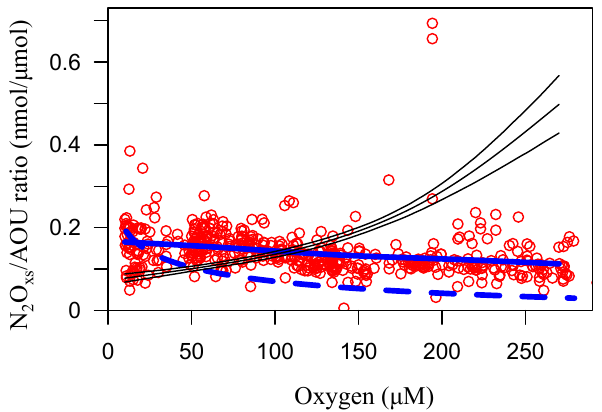
Fig. 5. N 2 O xs /AOU ratios vs. O 2 concentrations for MEMENTO profiles shown in Fig. 2. The thick, solid blue line is a spline (cubic smoothing) of the best fit for the data, with individual data shown in red. The dashed blue line indicates the expected cumulative produc- tion rate if production were to follow the Goreau et al. (1980) data as parameterised in Nevison et al. (2003), their Eq. (6). Thin black lines are the spurious relationship (cubic smoothing splines for the median and 95% confidence interval) that would be expected if the data were randomised. As spurious correlations have the opposite signal as the data, the relationship between N 2 O xs /AOU vs. O 2 ob- served is